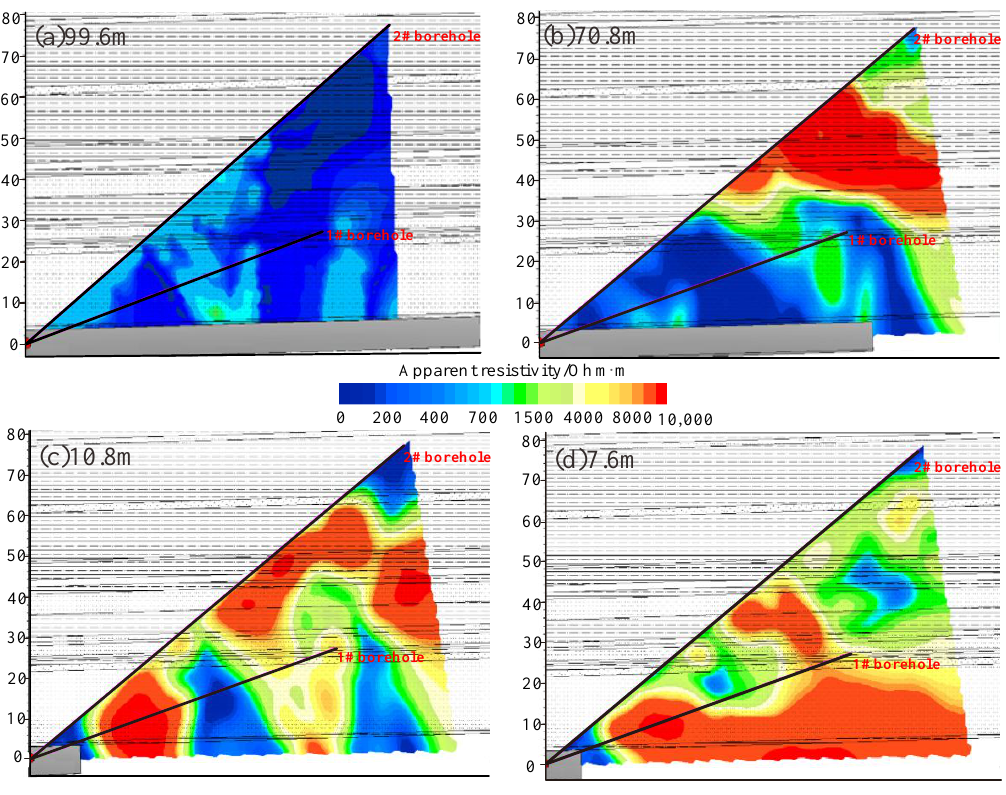
Figure 11. ( a – d ) depicts the dynamic distribution of overburden resistivity at the different distances between the mining face and the location of drillings (99.6 m, 70.8 m, 10.8 m, and 7.6 m). Process II: The initial stages of deformation and fracture development began to de- velop once the coalface advanced to a certain position between 99.6 m and 70.8 m away from the orifice. The deformation mainly occurred in soft rock or sandstone strata along with relatively developed primary fractures. Figure 11b shows the resistivity change in the cross-section when the coalface was mined to 70.8 m. Process III: The rock mass in the monitoring area had undergone great deformation and displacement in the process of mining to 60 m. The structure of the rock mass had been altered, a large range of fracture zone had been generated, and the local bottom rock stratum had begun to fall. The local area of the goaf roof showed low resistivity charac- teristics, and the resistivity of the rock in most areas was relatively higher in Figure 11c. Process Ⅳ : Most of the overburdened strata were suspended above the goaf in this process. The rock mass was subjected to the highly concentrated stress, and thus the dam- aging effect on the overburdened strata accelerated the development of the fractures, causing immediate roof caving and deformation and the migration of the basic roof judged from the high resistivity of the monitoring area in Figure 11d. 5. Discussion From the perspective of strata deformation mechanics, the critical conditions of strata movement and failure are analyzed based on the thin plate structure model under an elas- tic foundation. The maximum principal stress is affected by the thin plate structure ’ s size and the coal pillars ’ maximum bending deflection. If it exceeds the ultimate strength the overburdened strata can bear, they will be deformed and destroyed.